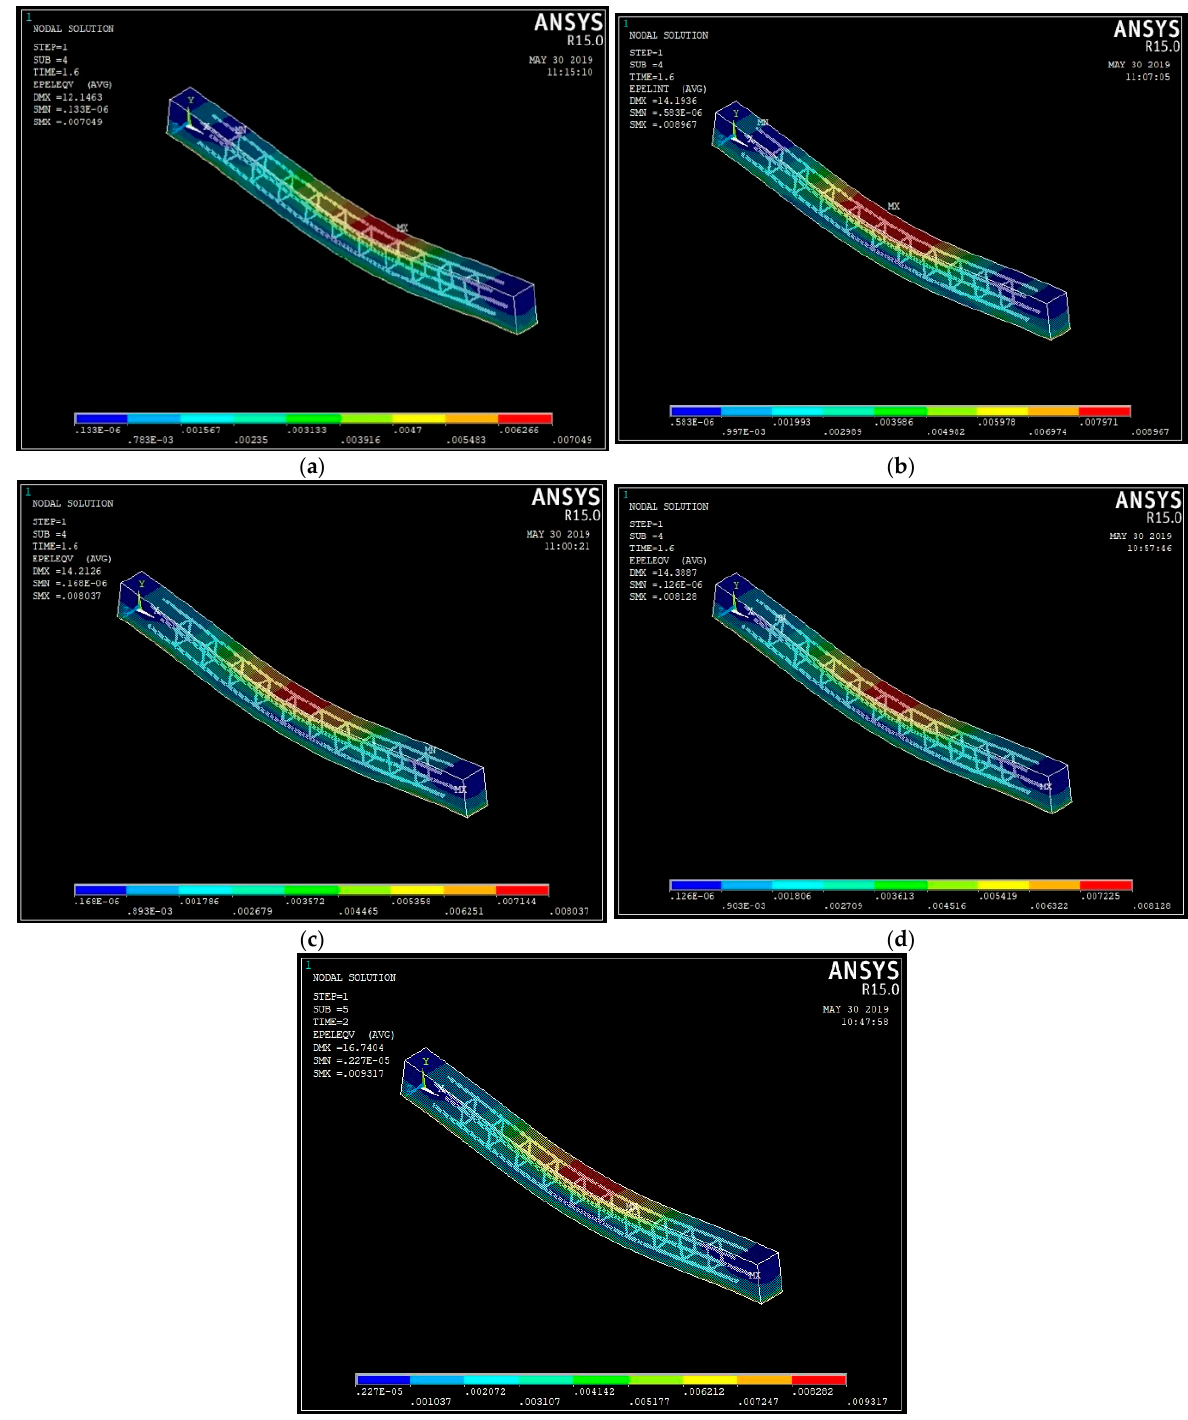
Figure 14. The strain plot of the steel fiber-reinforced coconut shell concrete beams: ( a ) CS; ( b ) CSF25; ( c ) CSF50; ( d ) CSF75; ( e ) CSF100.